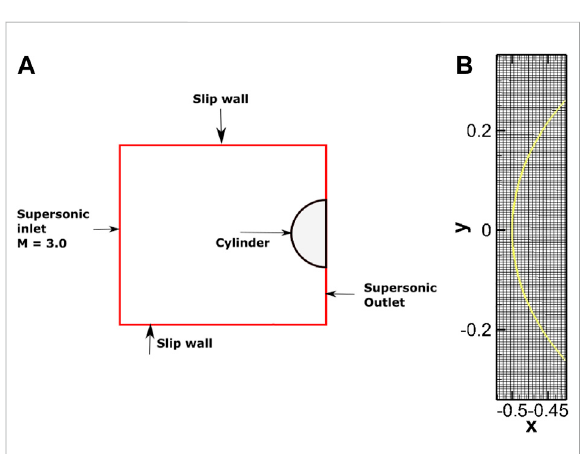
FIGURE 12 Schematic representation of the domain with boundary conditions indicated (A) and near-view of the grid showing every other pair of grid lines (B) ; IB shown by the yellow line.